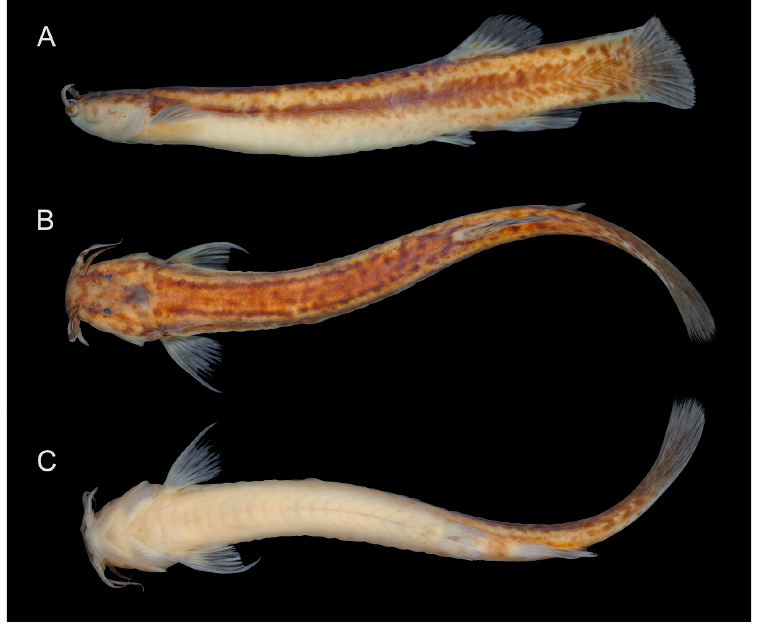
Figure 15. Trichomycterus (Paracambeva) sainthilairei . Holotype, UFRJ 10215, Capitólio, 65.4 mm SL: ( A ) lateral, ( B ) dorsal, and ( C ) ventral views. Diagnosis. Trichomycterus septemradiatus is distinguished from all other species of Paracambeva , except for T. adautoleitei , T. anaisae , T. funebris , T. ingaiensis , and T. luetkeni by having seven pectoral- fi n rays (vs. six in all other species of the T. reinhardti group). Trichomycterus septemradiatus di ff ers from T. adautoleitei by having fewer ventral procurrent caudal- fi n rays (10 vs. 13), a longitudinal body stripe with di ff use margins, which is weakly contrasting with the pale yellow ground of the fl ank (vs. well delimited black stripe, strongly contrasting with the yellow ground of the fl ank), the absence of round black spots on the dorsum body (vs. presence), and the presence of a longitudinal row of small black spots on the dorsal portion of the fl ank (vs. absence); from T. anaisae and T. luetkeni by having fewer dorsal (15 vs. 21–23) and ventral (10 vs. 15–17) procurrent caudal- fi n rays; from T. anaisae by the absence of two rows of black spots overlapping the longitudinal body stripe (vs. presence); from T. funebris by having a shorter latero- posterior process of the autopalatine, with its length being about half of the autopalatine length (vs. about two-thirds), and the anal- fi n origin at vertical through the centrum of the 23rd vertebra (vs. 25th or 26th); and from T. ingaiensis by having the anal- fi n origin at vertical between the base of the fi fth dorsal- fi n ray (vs. base of the seventh and ninth dorsal- fi n rays). For a full description and anatomical illustrations, see Costa and Ka tz (2021). Distribution. Trichomycterus septemradiatus occurs in the Rio Sapucaí subdrainage, Rio Grande drainage, Rio Paraná basin, at altitudes between about 855 and 1040 m asl (Figure 3C).